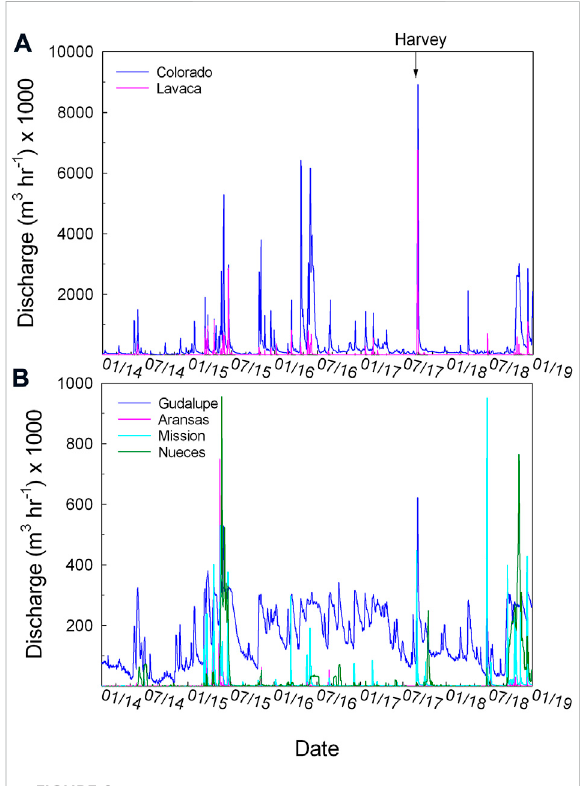
FIGURE 2 River discharge during the period of 2014 – 2018. The arrow points to the date of Hurricane Harvey landfall near San Jose Island, Texas, at the southern end of the Mission-Aransas Estuary. The Lavaca and Colorado rivers empty into LCE, the Guadalupe River empties into GE, the Mission and Aransas rivers emptyintoMAE,andtheNuecesRiveremptiesintoNE.Lavacaand Colorado rivers (A) and all four other rivers (B) are separately plotted to show the large differences in their discharge (note the vertical